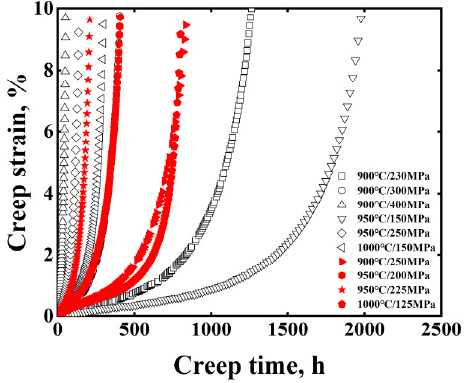
Figure 1. Creep curves obtained under different conditions for MarM247LC superalloy. The black curves were used for fitting the Larson–Miller parameter and training the model; the red ones were used to validate the model.